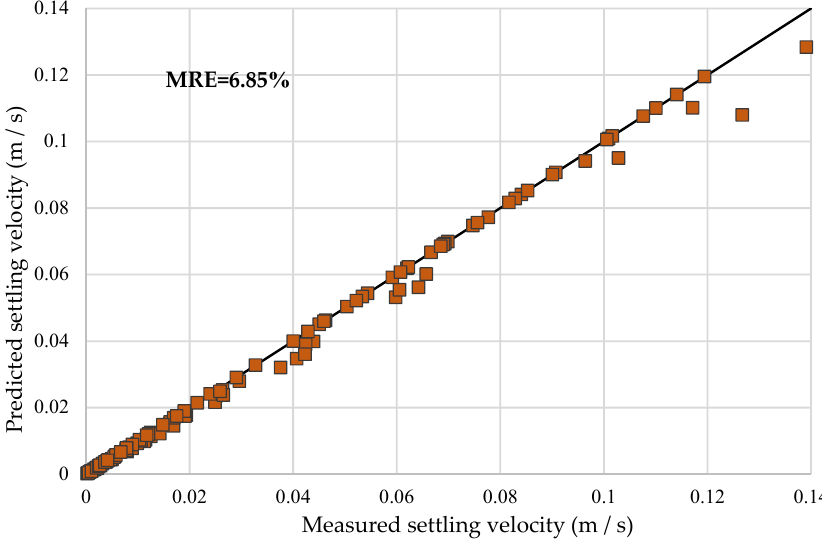
Figure 10. Comparison between the predicted value and the experimentally measured value of settling velocity of spherical particles. Table 4. Error Statistics of Drag Coefficient of Spherical Particles Settlement in Herschel–Bulkley Fluid.